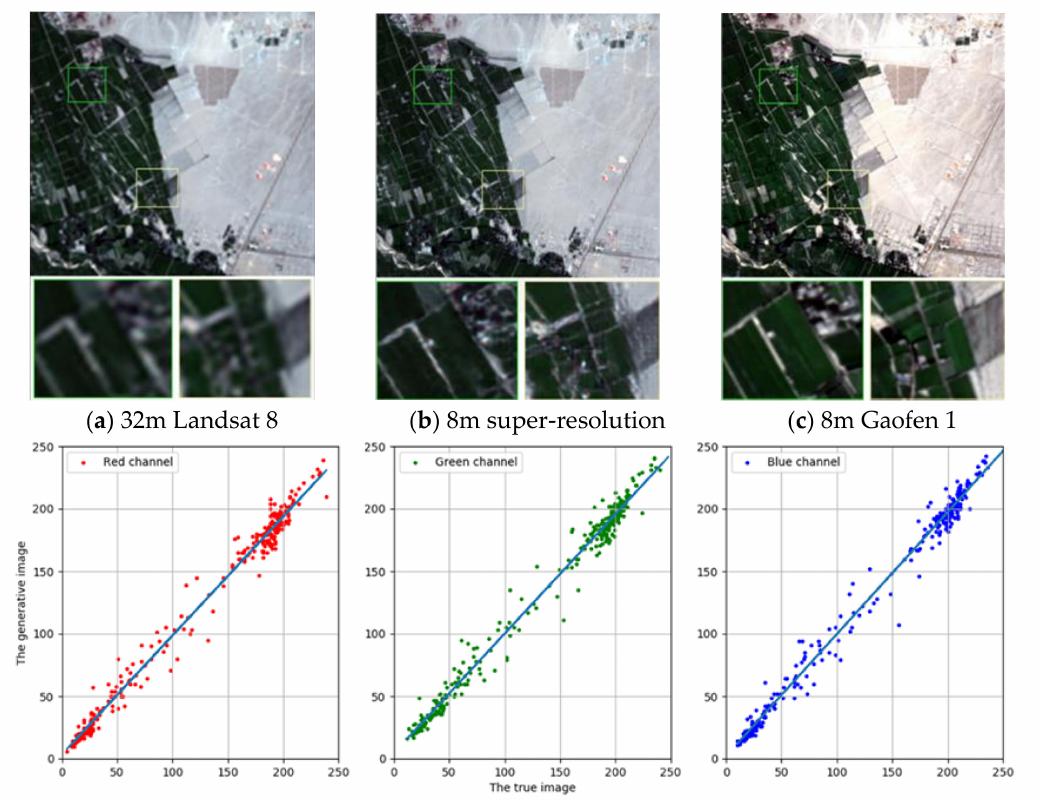
Figure 6. Cross-sensor and -location comparison: the predicted super-resolution image for our ISRGAN model ( b ) on a Landsat 8 dataset in Xinjiang, compared to the input image ( a ) and the ground truth ( c ). Figures ( d ), ( e ), and ( f ) are 1:1 plots of the DN value in the red, green and blue bands compared to the ground truth ( c ), with slopes of 0.9527, 0.9564 and 0.9760, respectively.